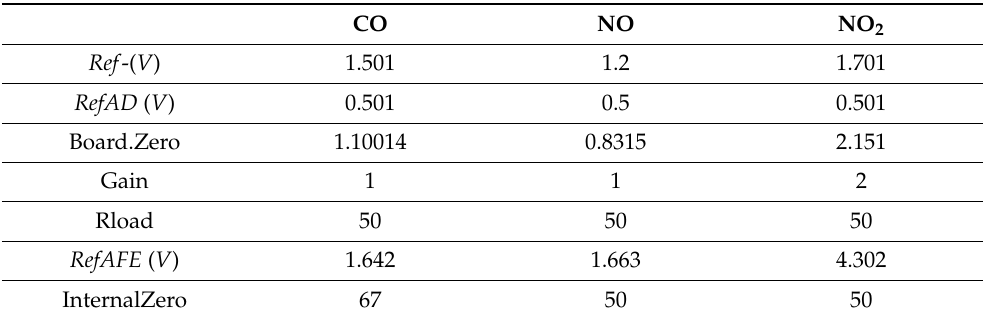
Table 4. Parameters for configuration of chemical sensors in